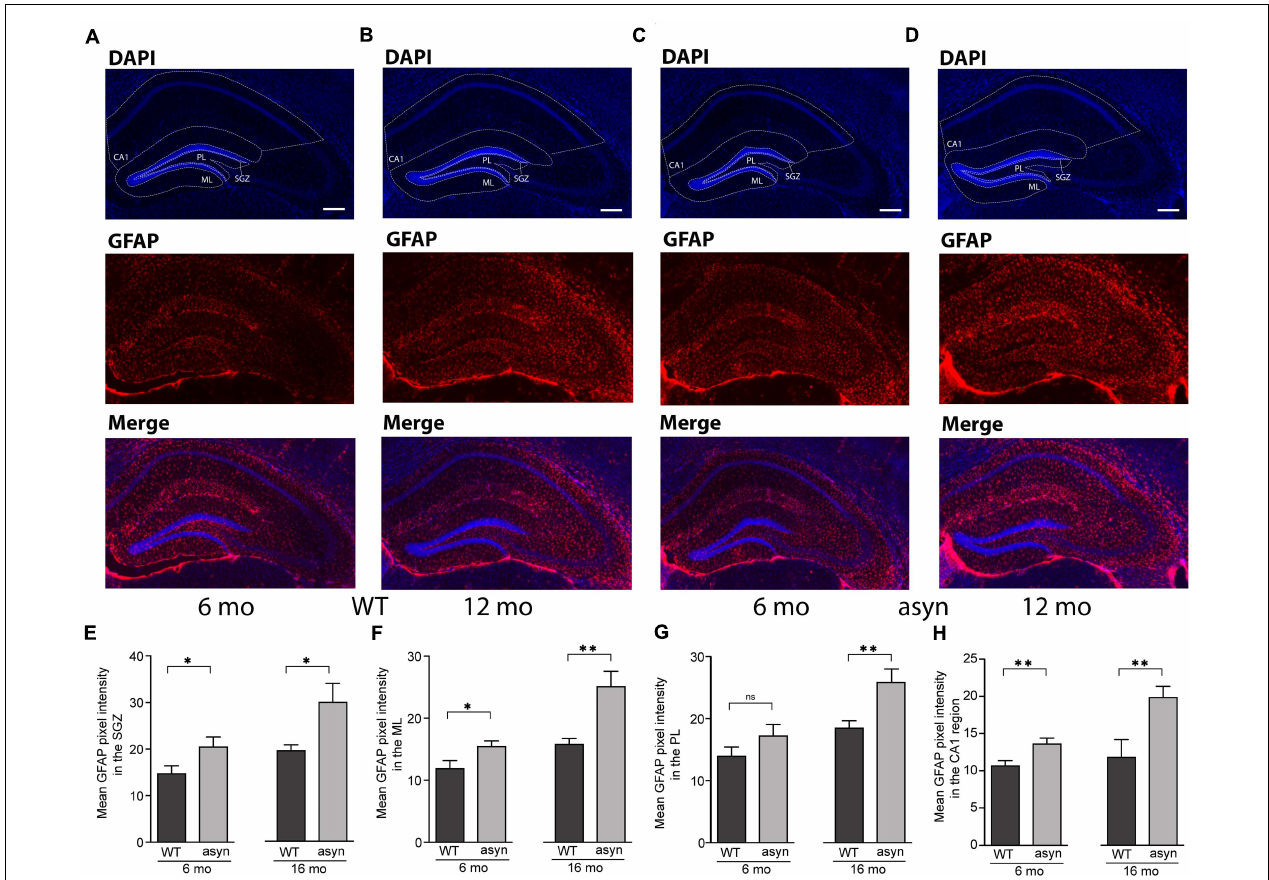
FIGURE 4 | GFAP signal intensity in the hippocampal dentate gyrus and CA1 region of wildtype and Thy1-aSyn mice. (A–D) Immunofluorescence for GFAP (red) and DAPI staining (blue) and merged images of 6 and 16-month-old wildtype [WT, (A,B) ] and 6 and 16-month-old Thy1-aSyn [asyn, (C,D) ] mice. (E–H) Mean GFAP pixel intensity in the subgranular zone (SGZ), molecular layer (ML), polymorph layer (PL) and CA1 region of 6- and 16-month (mo)-old wildtype (WT) and Thy1-aSyn (asyn) mice. Data represent mean ± SEM. ( n = 6/group; Student’s t -test; ∗ p < 0.05; ∗∗ p < 0.01). Scale bars, 50 µ